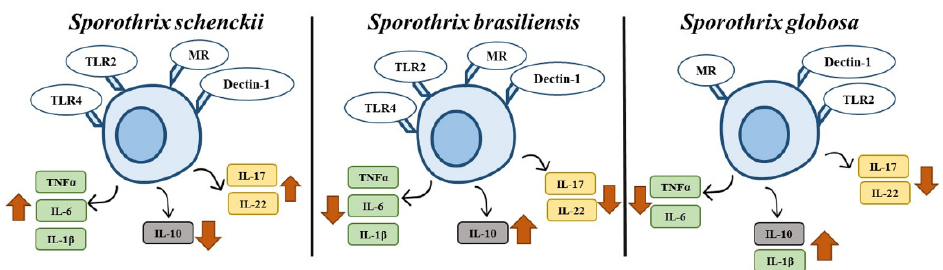
Figure 9. Cytokine profiles of human peripheral blood mononuclear cells stimulated with Sporothrix schenckii , Sporothrix brasiliensis , or Sporothrix globosa . When human cells interact with S. schenckii , there is an increased production of proinflammatory cytokines and low IL-10 stimulation. In the case of S. brasiliensis , there is a low stimulation of proinflammatory cytokines but high levels of IL-10. A similar cytokine profile was observed when human PBMCs were stimulated with S. globosa, with the exception of IL-1 β . The receptors involved in the sensing of these three fungal species are mannose receptor (MR), TLR2, dectin-1, and TLR4; however, this last one is dispensable for cytokine stimulation by S. globosa .